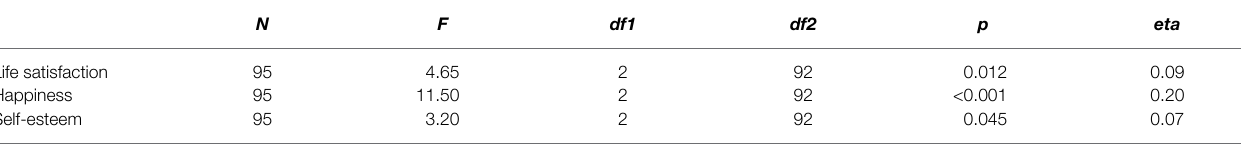
TABLE 3 | Comparison of life satisfaction, happiness, and self-esteem in the participants who completed second measurement separately for the group of active, beginners, and inactive people.